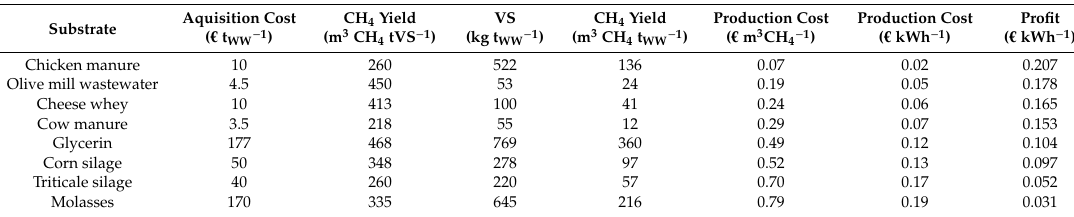
Table 4. Cost and profit for each